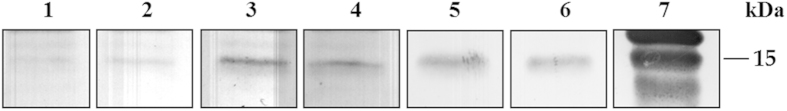
Immunoblot after immunoprecipitation with anti-ACR2 antibody from roots (lanes 1–2) and fronds (lanes 3–4) of P. vittata sporophytes treated or not with 334 μM As, and gametophytes (lanes 5–6) treated or not with 8 mM As.Controls: lanes 1, 3, 5; arsenic treatment: lanes 2, 4, 6. Recombinant ACR2 (lane 7) was used as a positive control of immunoprecipitation.